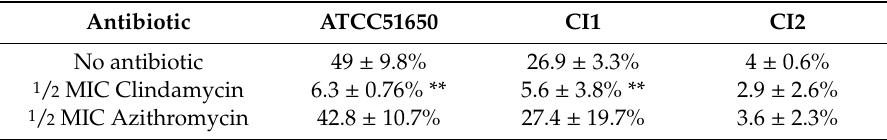
Figure 5. Sub-inhibitory clindamycin and azithromycin can modulate the inflammatory response of HNECs exposed to S. aureus exoproteins. IL6 ( a ) and IL8 ( b ) protein concentration in HNEC culture medium after a 24-h challenge with 5% S. aureus exoproteins untreated (no antibiotic, grey bars) or treated with 1 / 2 , 1 / 4 or 1 / 8 MIC clindamycin (blue bars) or azithromycin (green bars) for 24 h. Positive control = 10 µ g / mL Poly (I:C) LMW; negative control = 5% tryptic soy broth in cell culture medium; Antibiotic control = 1 / 2 MIC clindamycin (dark blue) or azithromycin (dark green) in medium. n = 3. * p < 0.05 one-way ANOVA followed LSD post hoc comparison. Table 4. S. aureus intracellular infection rate. Cells were Giemsa stained and % of HNECs infected by S. aureus quantified and the average of three independent infection rates expressed as mean ± SEM. Compared with no antibiotic treatment, 1 / 2 MIC clindamycin significantly reduced intracellular infection rate of ATCC 51650 and CI1 (** p <